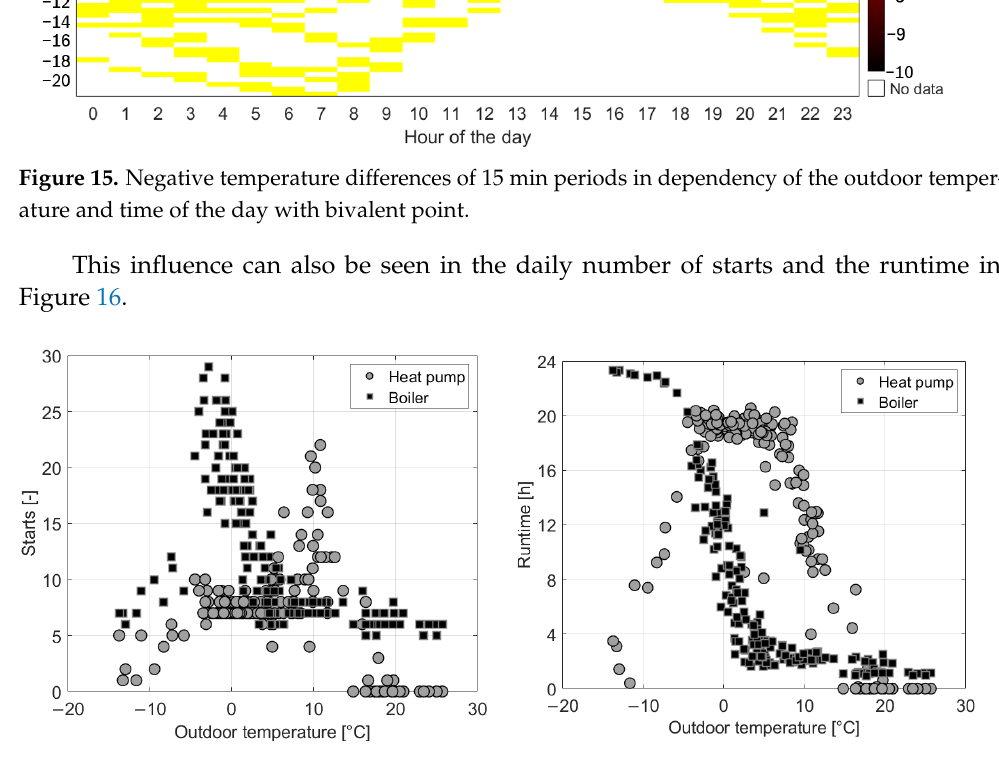
Figure 16. Number of daily starts ( left ) and runtime ( right ) of the heat pump and